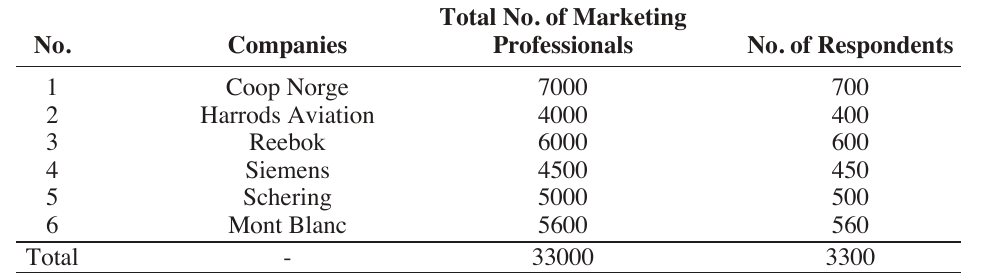
Table .1 Target Population and Selected Number of